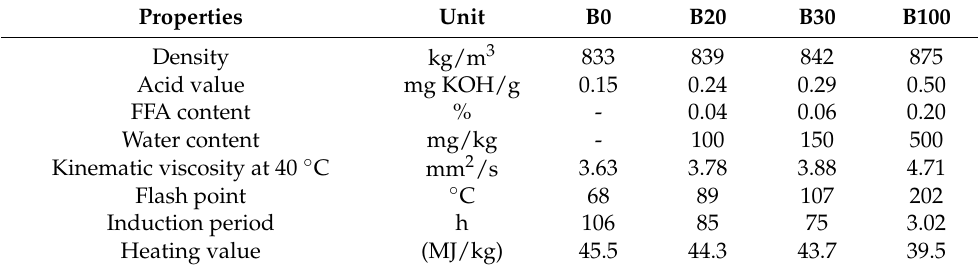
Table 2. Characteristics of pure diesel and biodiesel